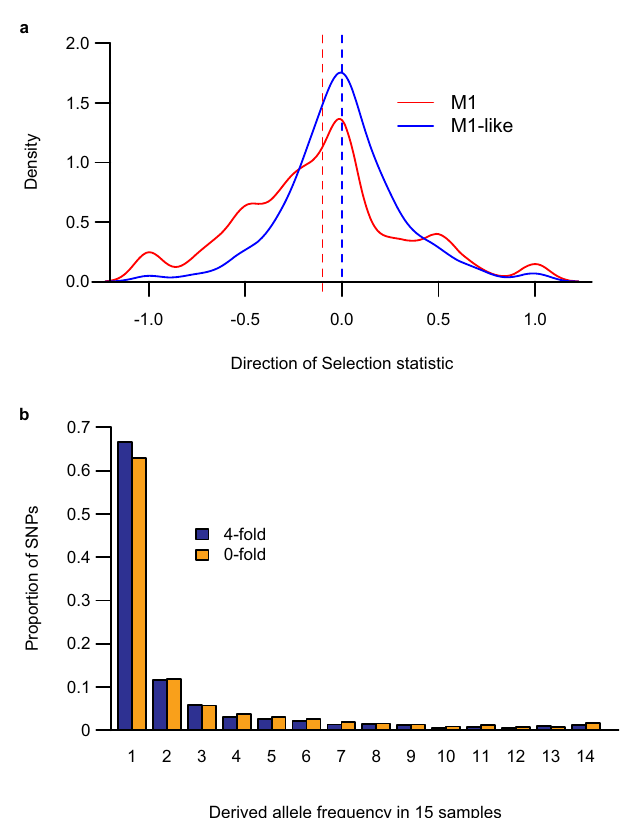
Fig. 6 Synonymous and nonsynonymous nucleotide polymorphisms in M1 and M1-like. a Direction of Selection (DoS) values for M1 and M1-like. The density plots show the distribution of the DoS statistic in M1 (red) and M1- like (blue) for 903 genes with de fi ned values of DoS in both lineages. Vertical dashed lines indicate the median DoS value for each lineage. b Unfolded site frequency spectra of SNPs at 1102 fourfold (blue) and 4583 zerofold (yellow) degenerate sites in